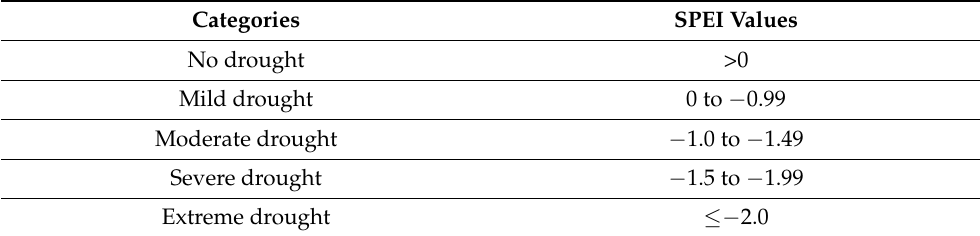
Table 1. SPEI Classical Table (adapted from